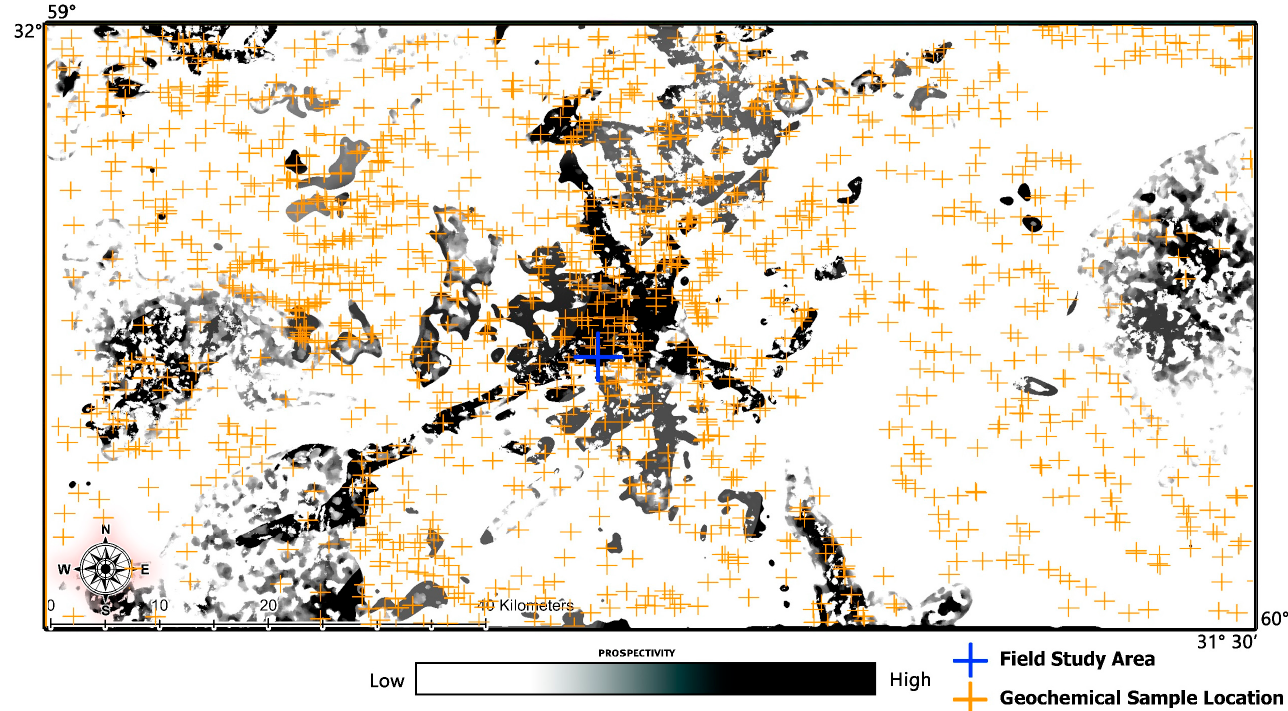
Figure 22. The metallic prospectivity map of the study area based on hybrid Fuzzy-AHP integrating method.